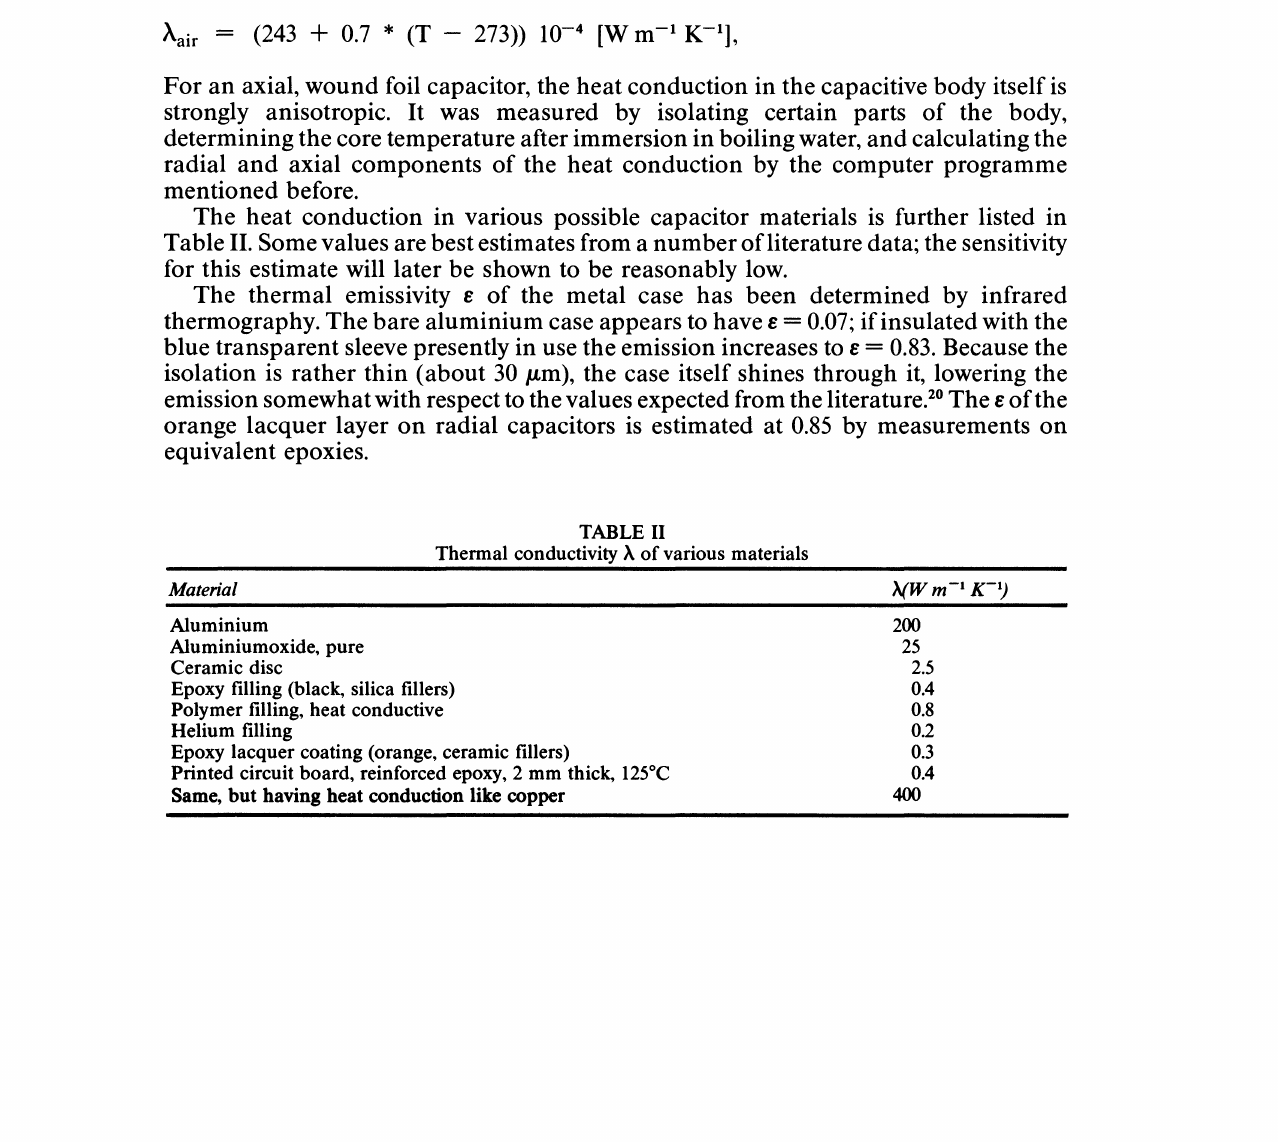
FIGURE 8 Thermal conductivity h of air as a function of temperature. See Ref. 19 for data.